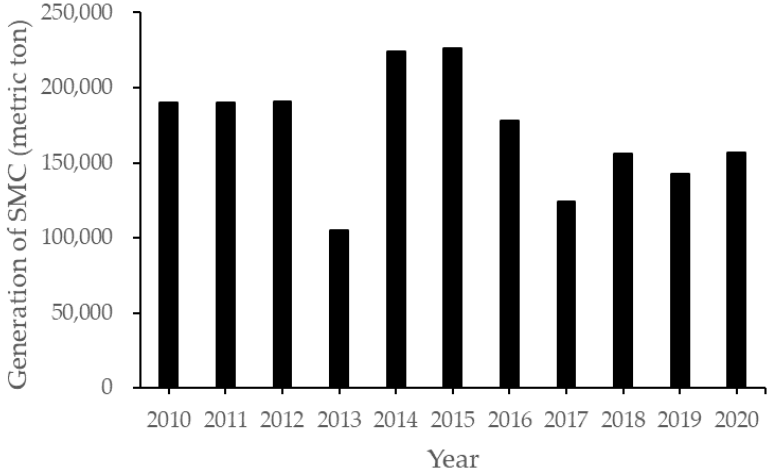
Figure 1. Reported amounts of spemt mushroom compost (SMC) generation in Taiwan since 2010